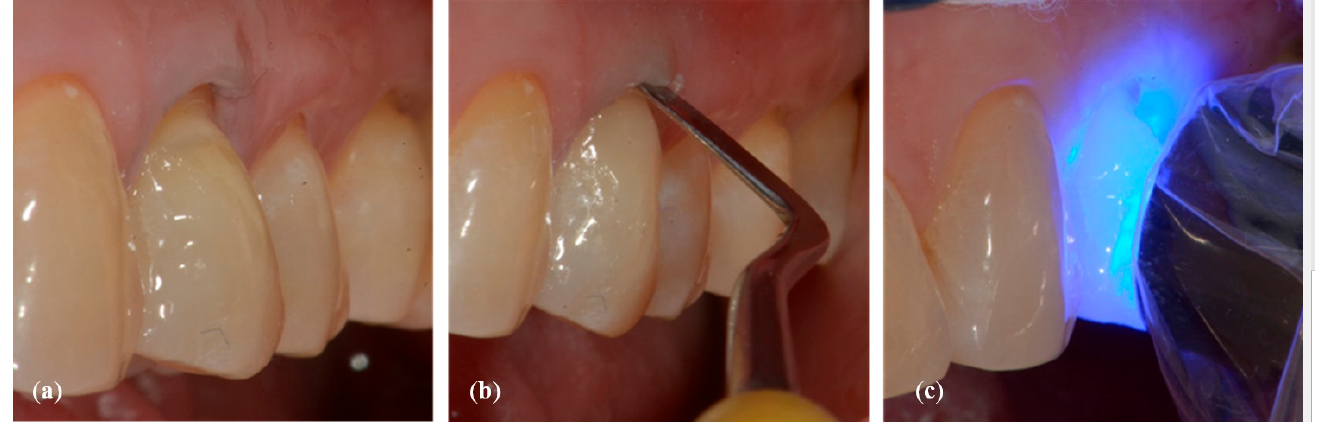
Figure 5. NCCL after etching.